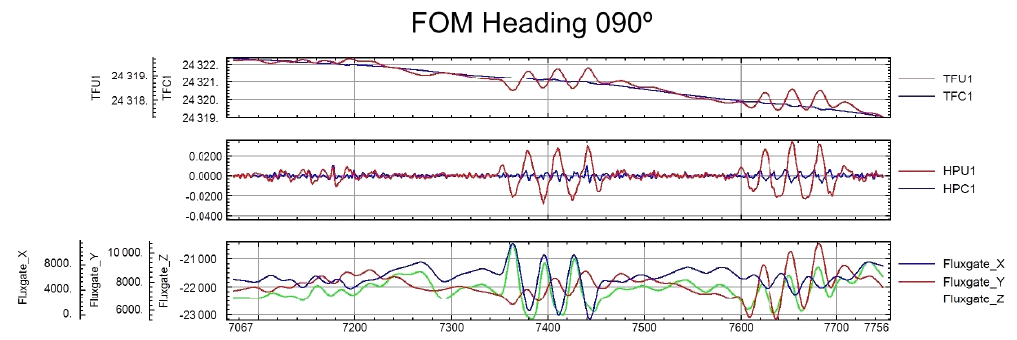
Figure 11. Example of magnetic field measurement interference caused by aircraft maneuvers (source: S. Guimarães, author private collec- tion, May 2007).